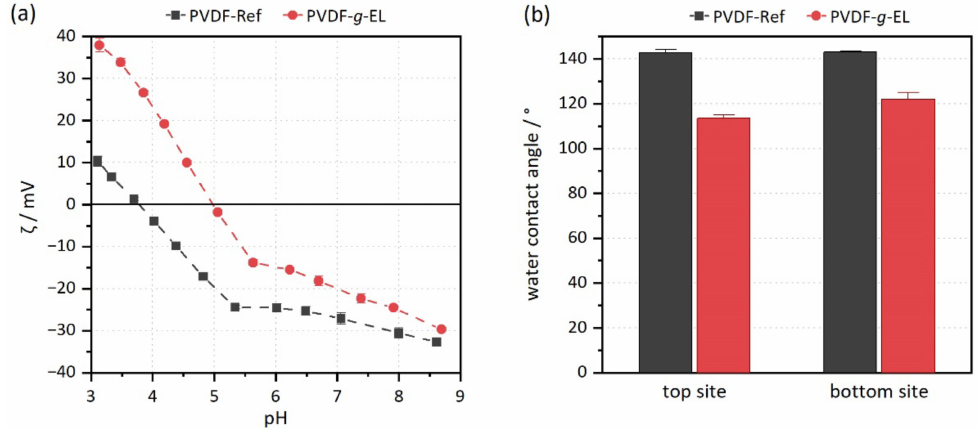
Figure 2. Characterization of surface properties. ( a ) Zeta potential curves; ( b ) contact angles of the top and bottom site of the membrane